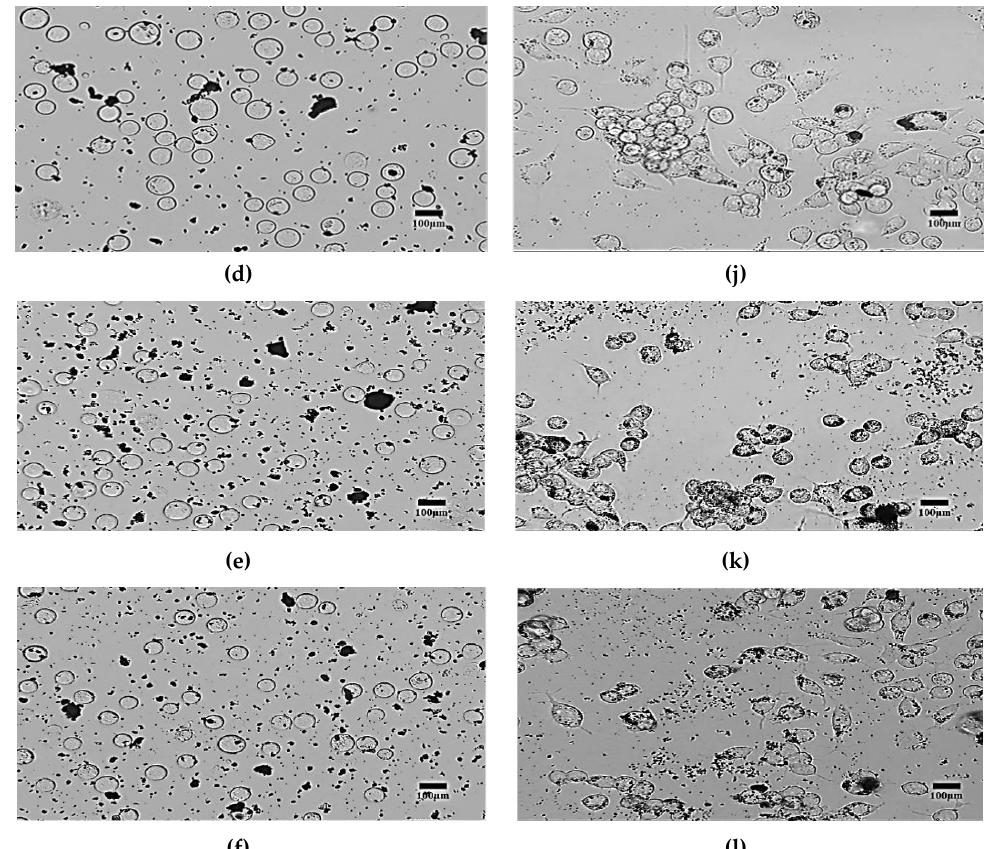
Figure 7. Photomicrographs of untreated and treated N2a cells at the initial time (T1) and after 72 hours’ (T8) incubation. Images in a , b , c , d , e , and f were taken at T1 while g , h , i , j , k , l at T8. a, g = untreated N2a; b, h = treated with 25 µ g / mL; c, i = 50 µ g / mL; d, j = 100 µ g / mL; e, k = 100 µ g / mL; f, l = 100 µ g / mL SPIONs concentrations. Scale bar 100 µ m.